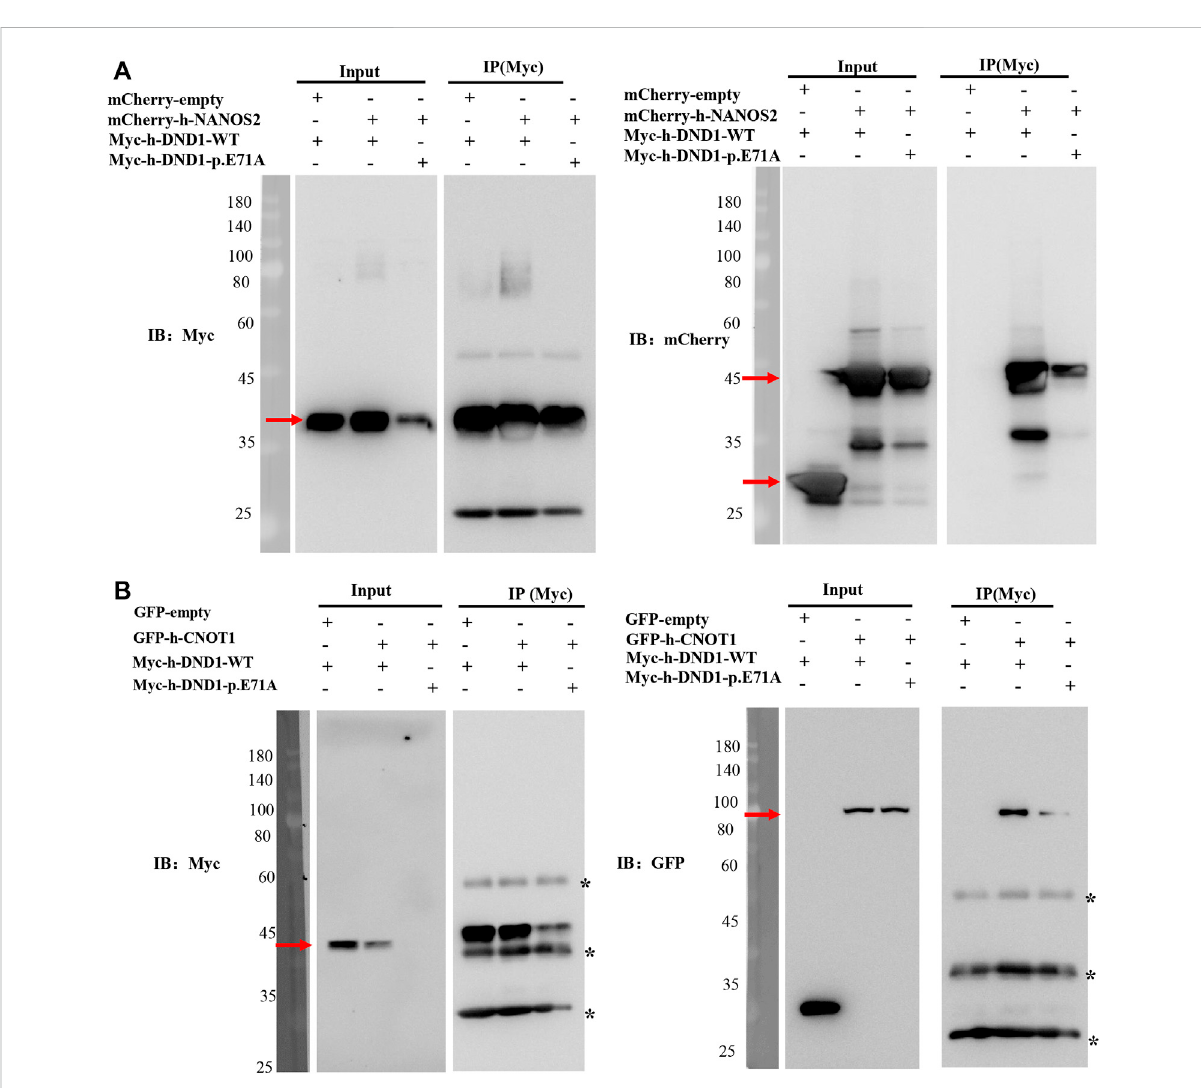
FIGURE 4 DND1 E71A Mutation disrupted its interactions with NANOS2. (A) HEK293T cells expressing the wild-type or mutant Myc-tagged DND1 protein and mCherry-tagged NANOS2 protein were immunoprecipitated with anti-Myc and immunoblotted with Myc and mCherry antibodies. (B) HEK293Tcellsexpressingthewild-typeormutantMyc-taggedDND1proteinandGFP-taggedCNOT1(1-551)proteinwereimmunoprecipitatedwith anti-Myc and immunoblotted with Myc and GFP